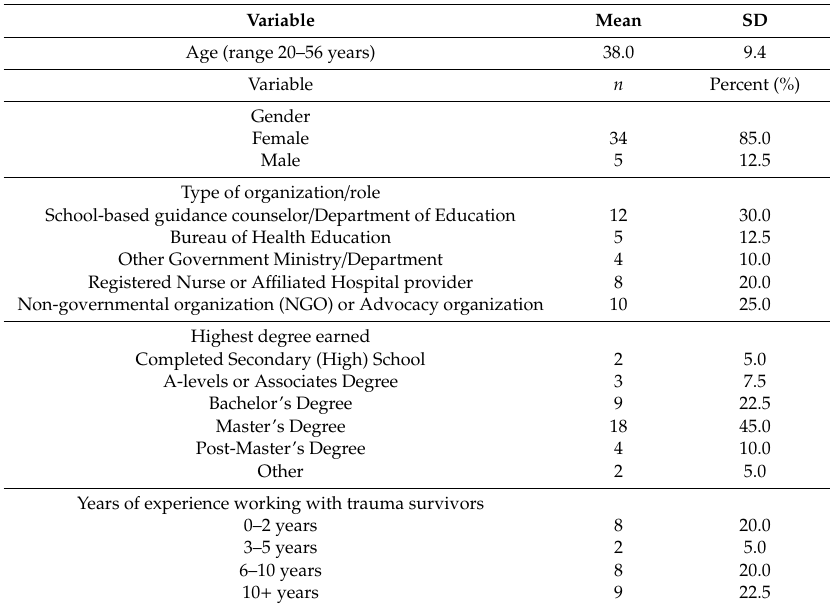
Table 1. Demographic characteristics of workshop